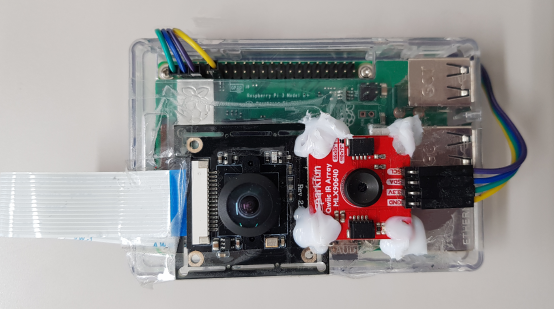
Figure 2. An image of the system built to collect the sensor frames and the camera